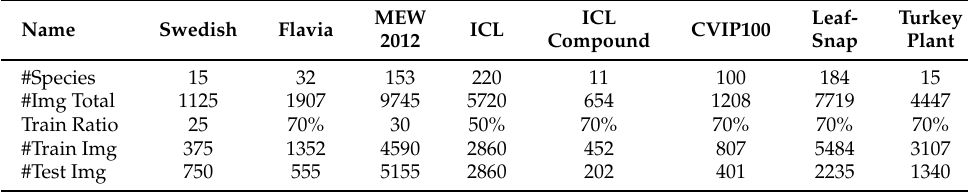
Table 1. Summary of the involved plant leaf databases.